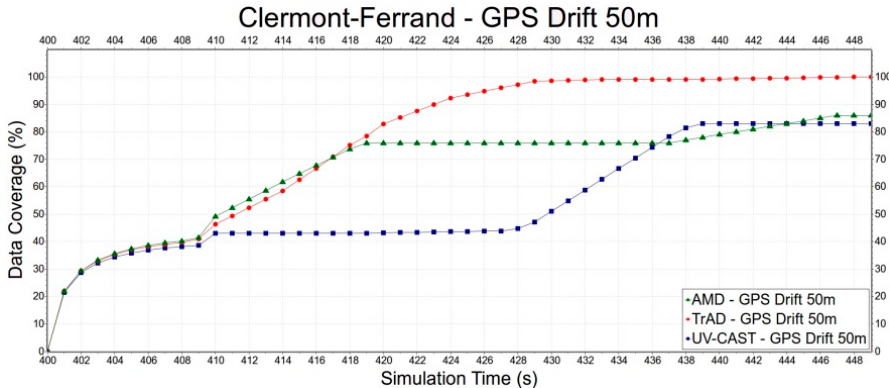
Figure 16. The data dissemination speed of TrAD, AMD and UV-CAST with 50 m GPS drift.